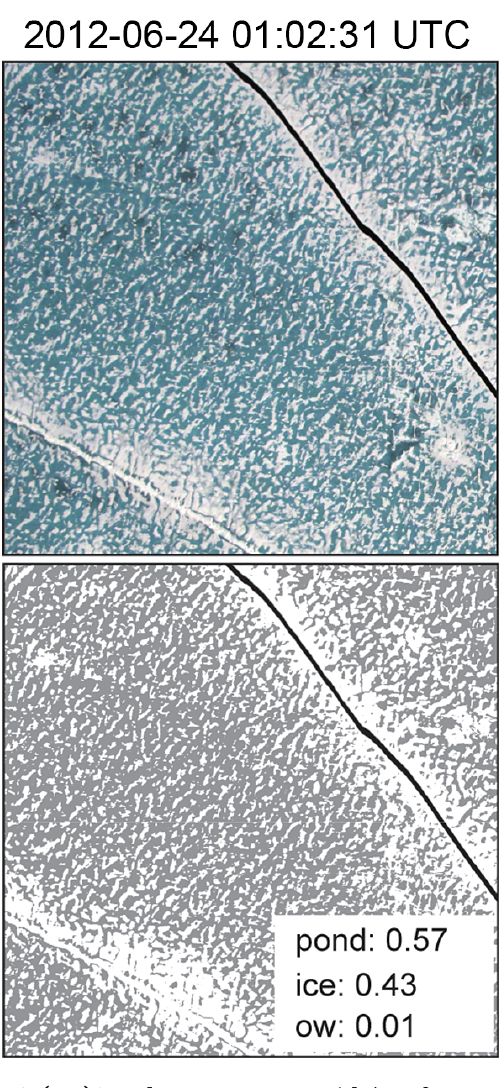
Figure 2. (Top) Sample 900m × 900m aerial photo from Parry site on 24 June. (Bottom) Decision-tree classification result with relative fractions of ponds (grey), ice (white) and open water